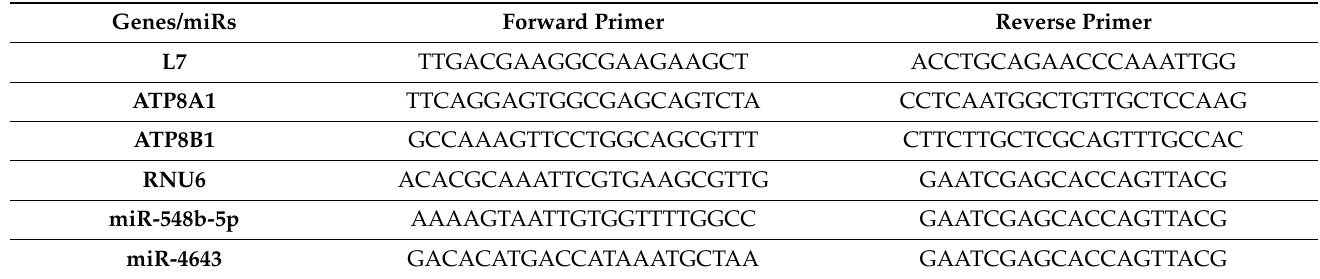
Table 2. Primers used in the